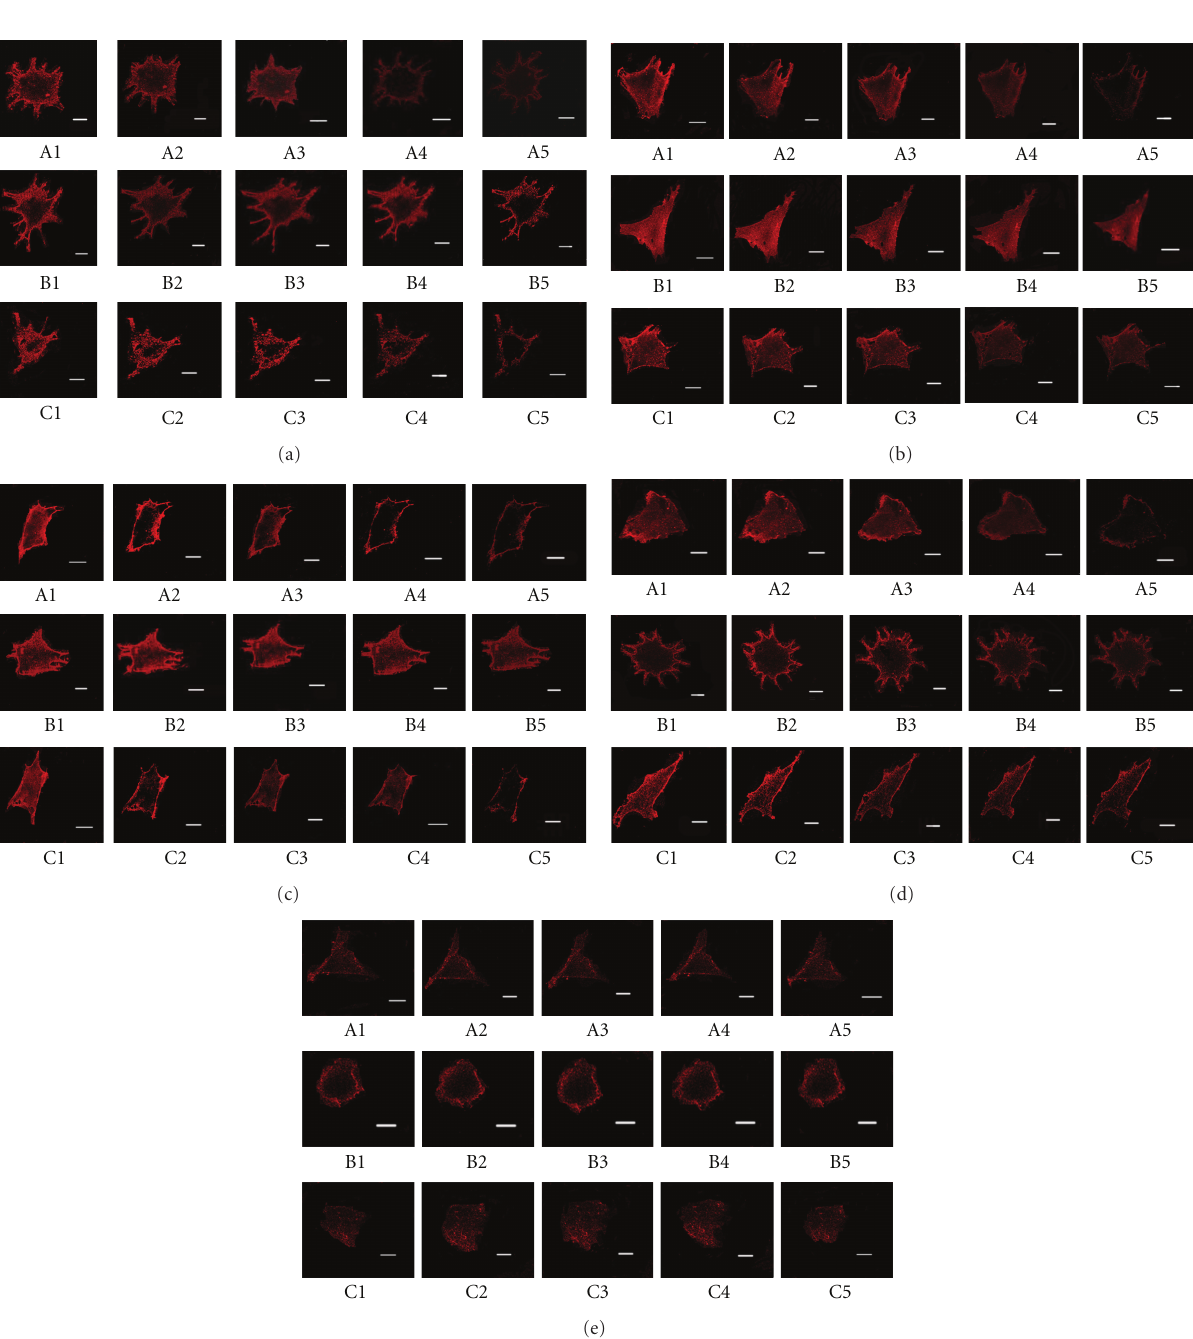
Figure 5: (a) Fluorescence images of integrin α 3 distribution (A: control group; B: injury group; C: verapamil-treated group; planes 1 → 5: basal surface → apical surface; scale bar = 10 μ m). (b) Fluorescence images of integrin α 5 distribution (A: control group; B: Injury group; C: verapamil-treated group; planes 1 → 5: basal surface → apical surface; scale bar = 10 μ m). (c) Fluorescence images of integrin β 1 distribution (A: control group; B: injury group; C: verapamil group; planes 1 → 5: basal surface → apical surface; scale bar = 10 μ m). (d) Fluorescence images of integrin β 5 distribution (A: Control group B: Injury group C: Verapamil group Planes 1 → 5: basal surface → apical surface; scale bar = 10 μ m). (e) Fluorescence images of integrin α 2 distribution (A: control group; B: injury group; C: verapamil group; planes 1 → 5: basal surface → apical surface; scale bar = 10 μ